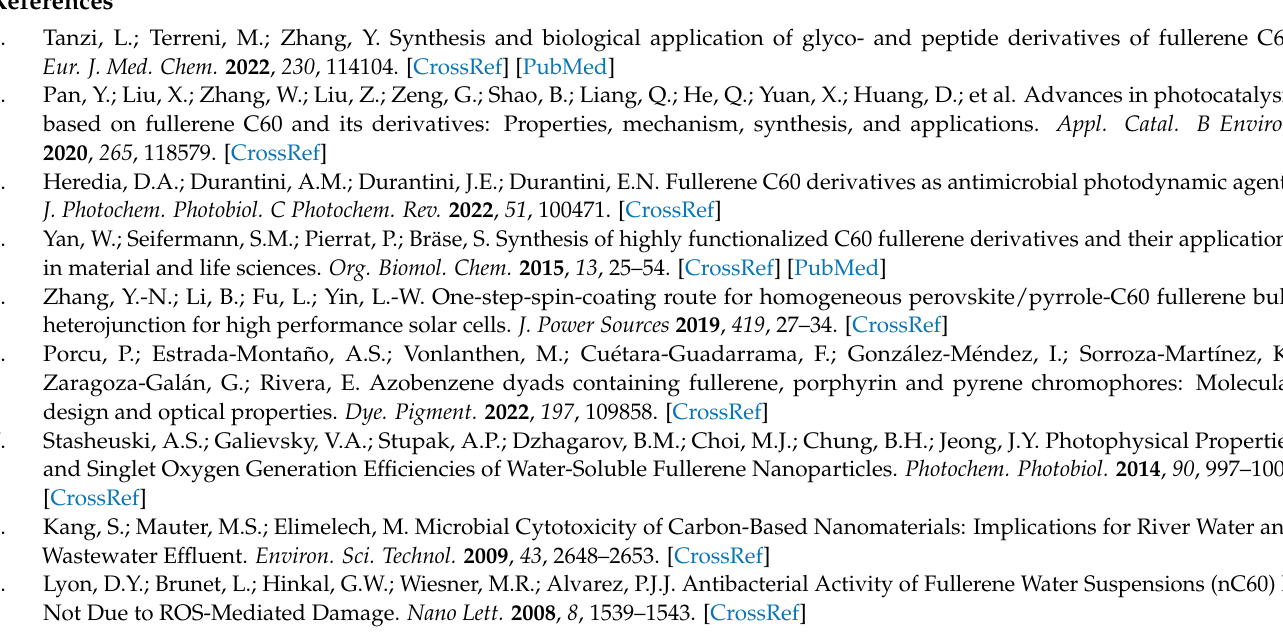
Figure S7: The TG and DTG curves for the CoTTP (a), C 60 (b) and PyC 60 (c) powder from 25 ◦ C to 920 ◦ C, with the heating rate of 10 ◦ C/min; Table S5: The peak potentials for CoTTP, C 60 /PyC 60 and triad based on them in CH 2 Cl 2 containing 0.1 M (n-Bu) 4 NClO 4 ; Figure S8: The